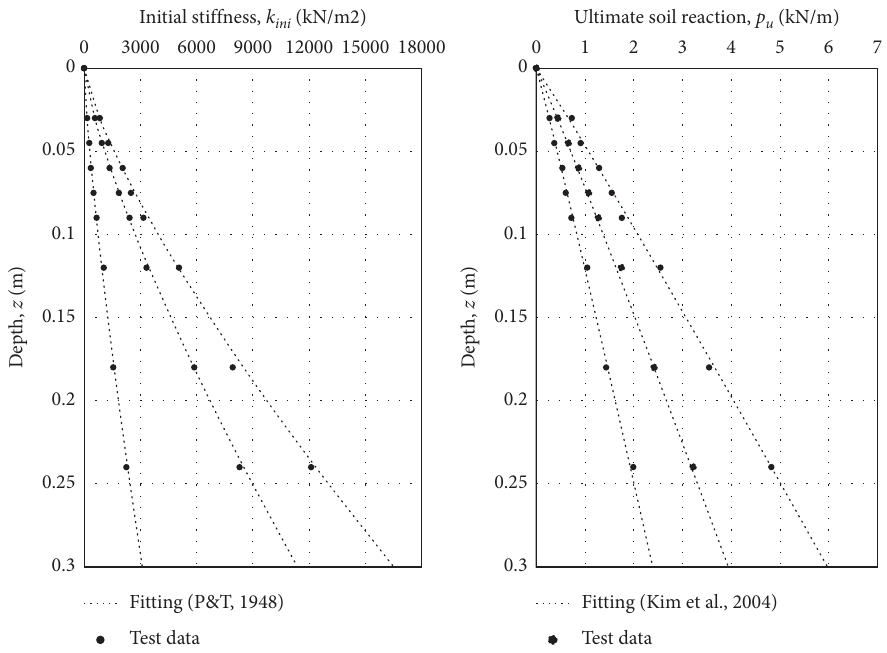
Figure 10: Initial stifness ( k ini ) and ultimate soil reaction ( p u ) with